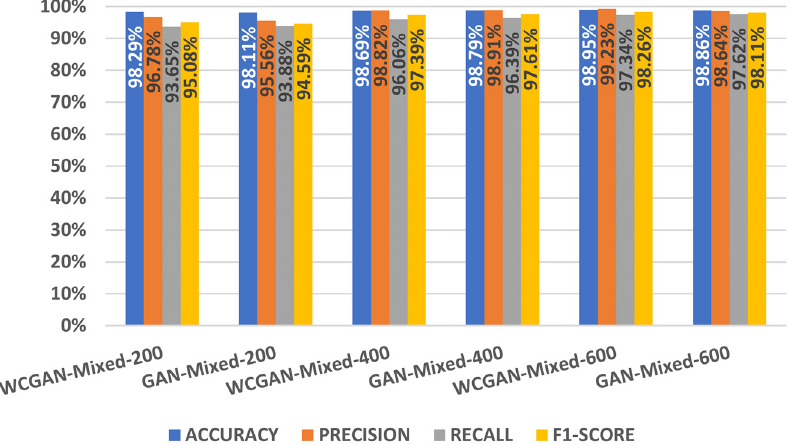
Figure 15. Histograms of the performance of our new GB-based classifiers on our mixed test sets.